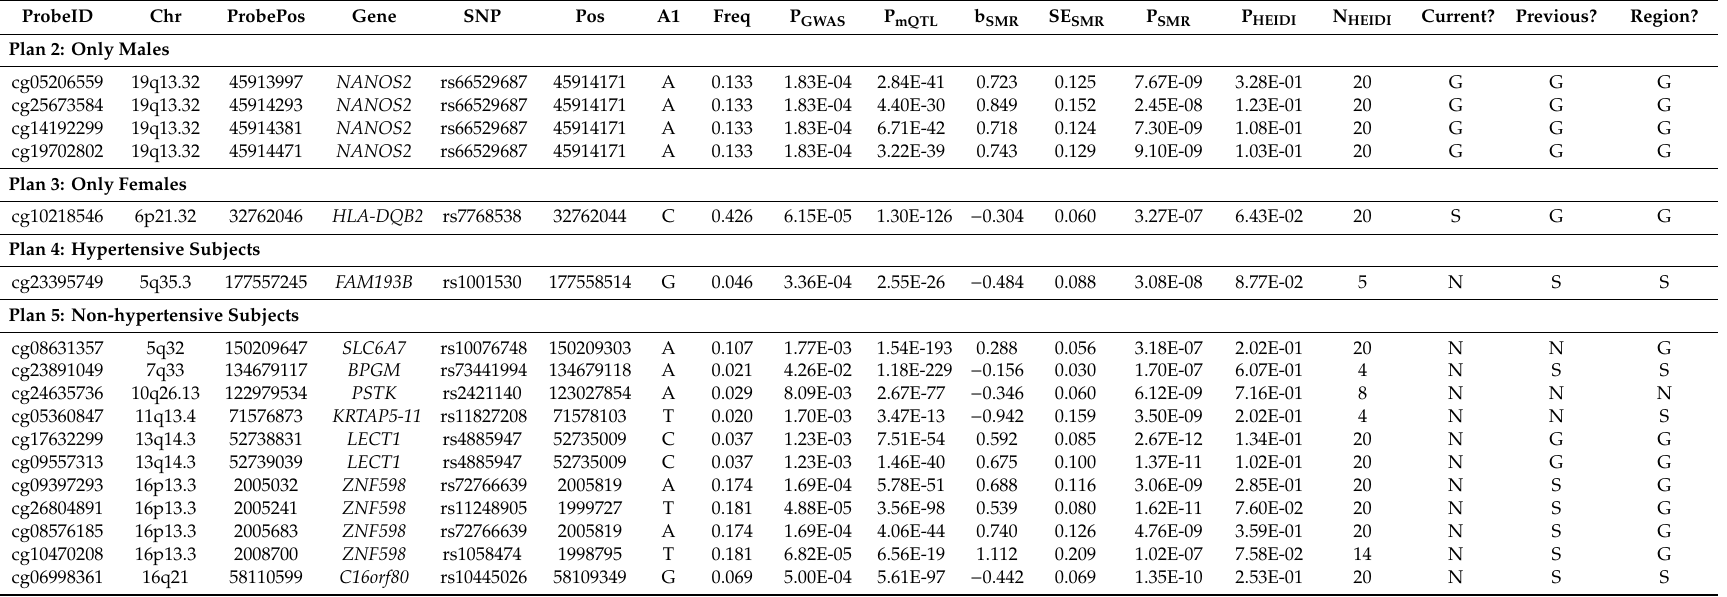
Table 1. Blood-based methylome-wide association results for genes that had significant probes in both brain-specific and blood-based